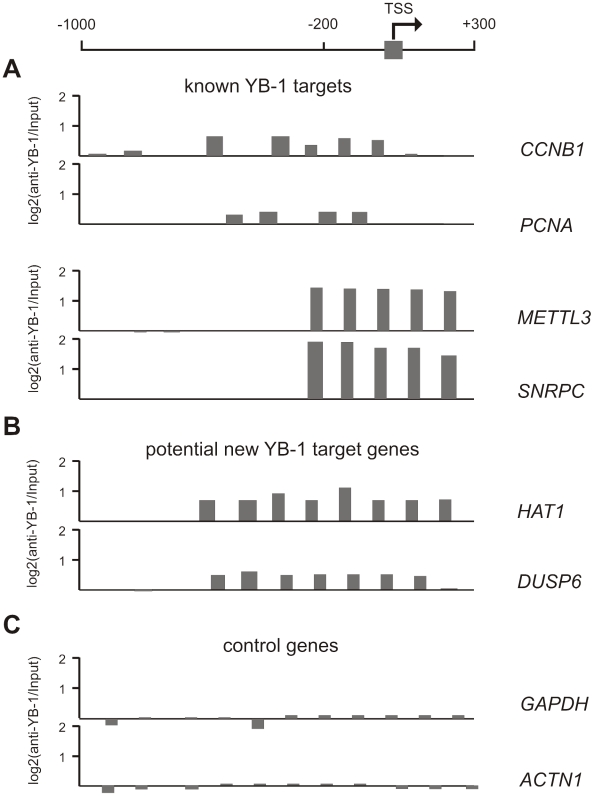
Genome-wide analysis of YBX1:DNA binding by chromatin-immunoprecipitation using NimbleGen ChIP-chip microarrays.The graph on top of the figure represents a schematic illustration of a promoter region (TSS – transcription start side). Extracts of HCT116 cells were used for ChIP-on-Chip analysis with specific antibodies directed against the C-terminus of YBX1. The Y-axis represents the ratio of hybridization intensities (on a log2 scale) of YBX1-precipitated DNA and input DNA. Size and number of the bars on the x-axis depict the enrichment of precipitated DNA fragments around the potential transcription start sites of known (A) and new (B) potential YBX1-target genes. (C) Non-target promoters. METTL3 (methyltransferase like 3) and SNRPC (small nuclear ribonucleoprotein polypeptide C) were recently identified as potential YBX1 target genes in basal-like breast cancer cells by ChIP-on-Chip assay [37]. (PCNA: proliferating cell nuclear antigen; HAT1: histone acetyltransferase 1; DUSP6: dual specificity phosphatase 6; GAPDH: glyceraldehyde-3-phosphate dehydrogenase; ACTN1: actinin, alpha 1).